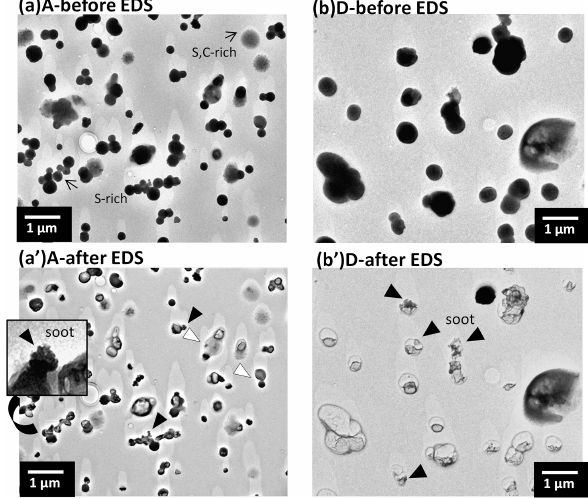
Figure 7. Electron microphotographs before and after EDS analysis of samples (a, a’) A and (b, b’) D. Soot is shown by black triangles in (a’) and (b’) . Non-soot residues are shown by white